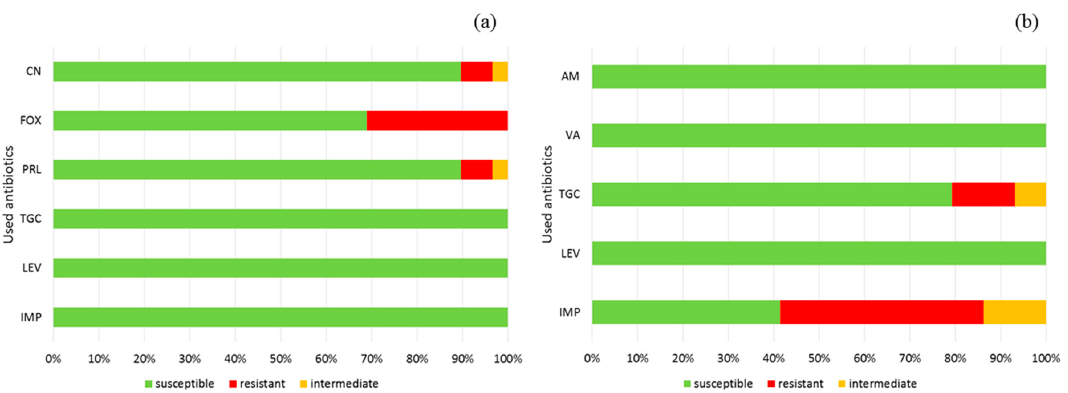
Figure 6. Antimicrobial resistance of isolated strains (n = 29) for Enterococcus ( a ) and Escherichia coli